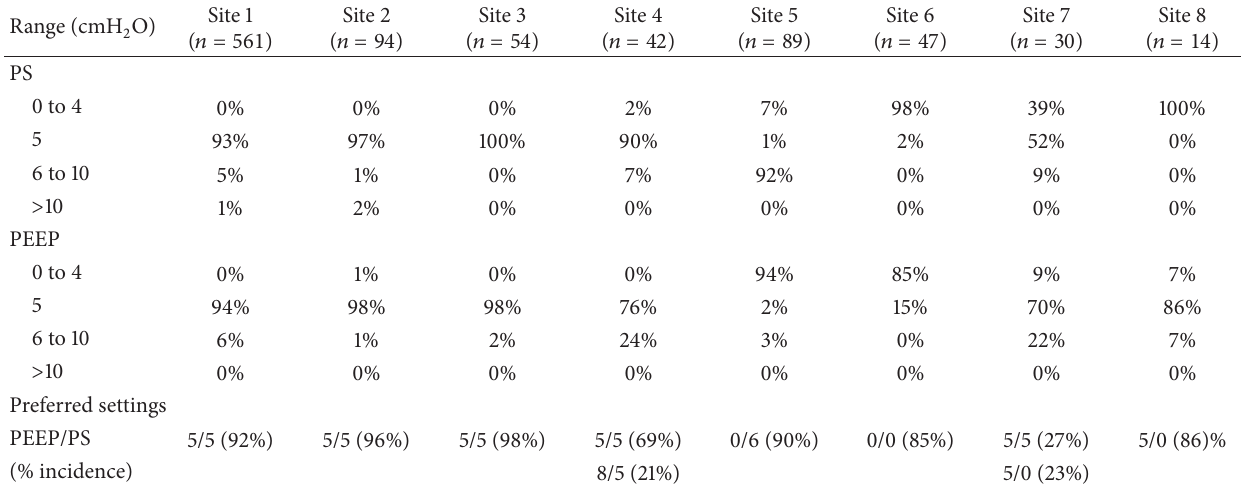
Table 2: Distribution of PS and PEEP ranges and preferred setting combinations (PEEP/PS). Range (cmH 2